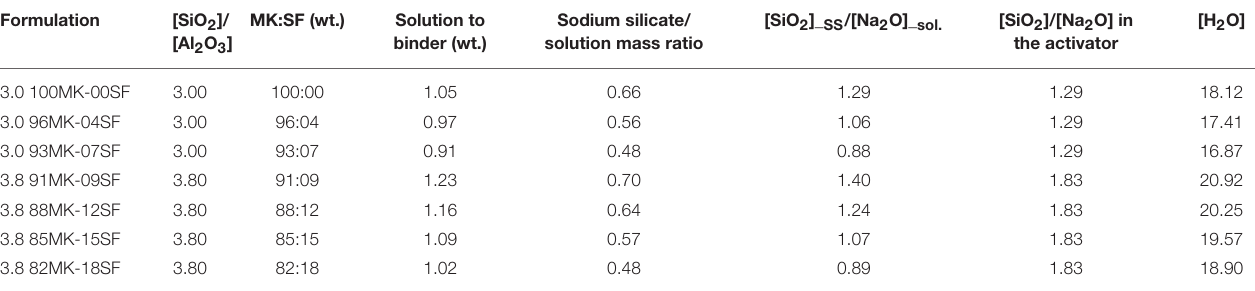
TABLE 1 | Mix design and activation parameters for the produced mortars.